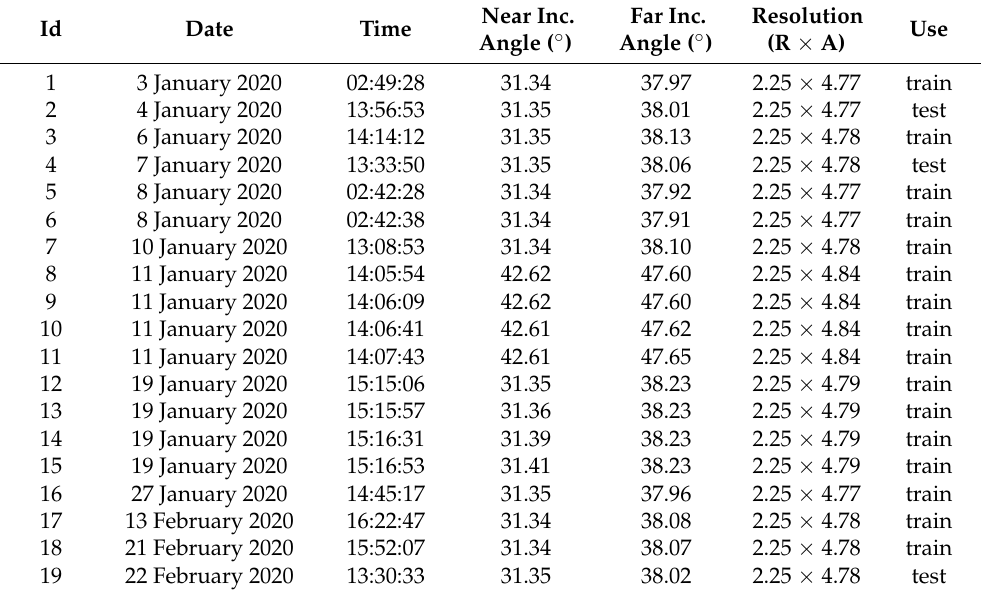
Table 1. Nineteen scenes of Gaofen-3 data (R for range, A for